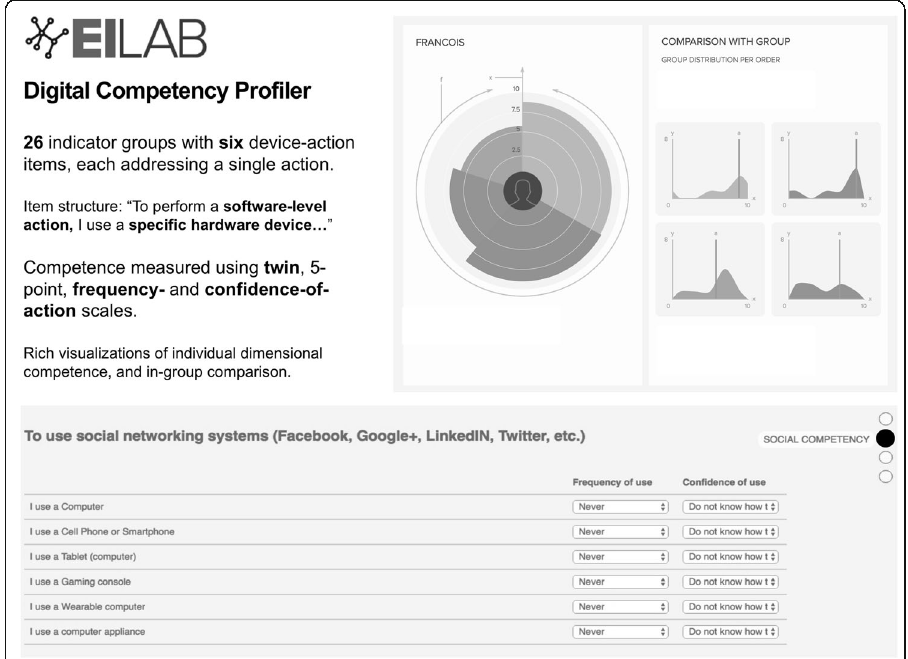
Fig. 2 Digital Competency Profiler, action-device groups and